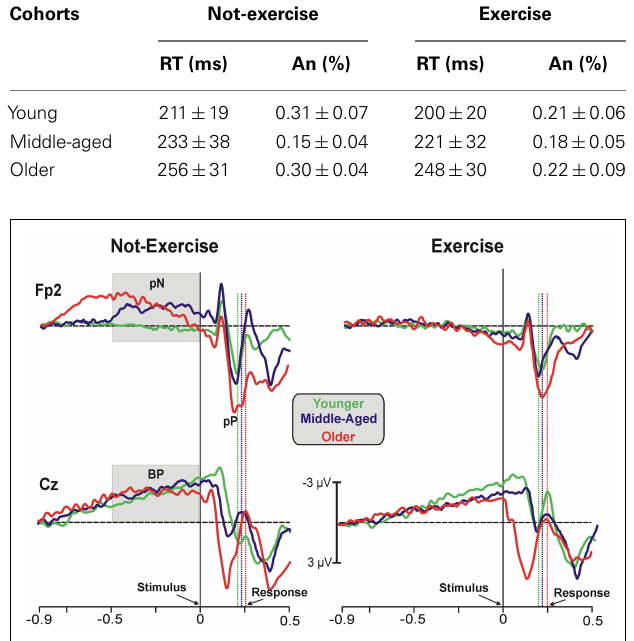
FIGURE 1 | Grand-average ERP waveforms at the prefrontal (Fp2) and central (Cz) electrodes .The age groups are superimposed with different colors (see the legend in the figure) and divided between not-exercise (left) and exercise (right) cohorts.The time zero represents the stimulus appearance; the vertical dotted lines represent the response emissions for each cohort, based on the color of the ERP waveforms.